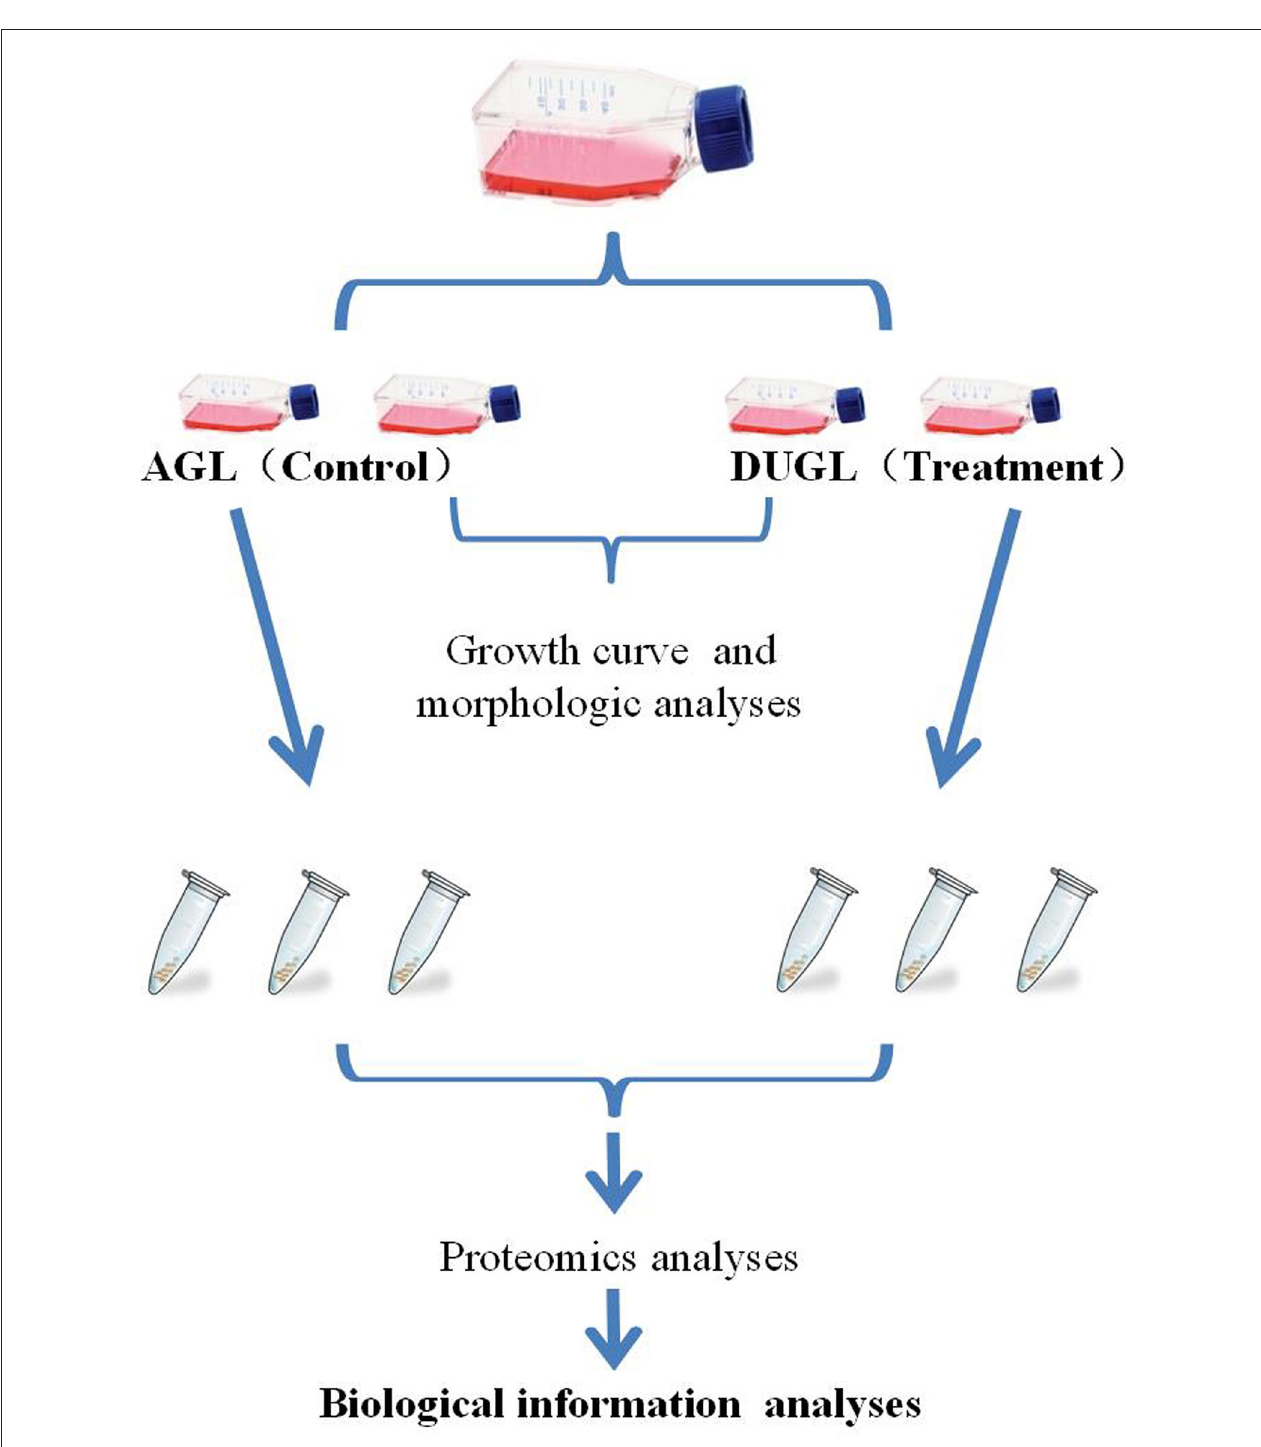
FIGURE 1 | Flow chart of the study design. AGL, above-ground laboratory; DUGL, deep underground laboratory.